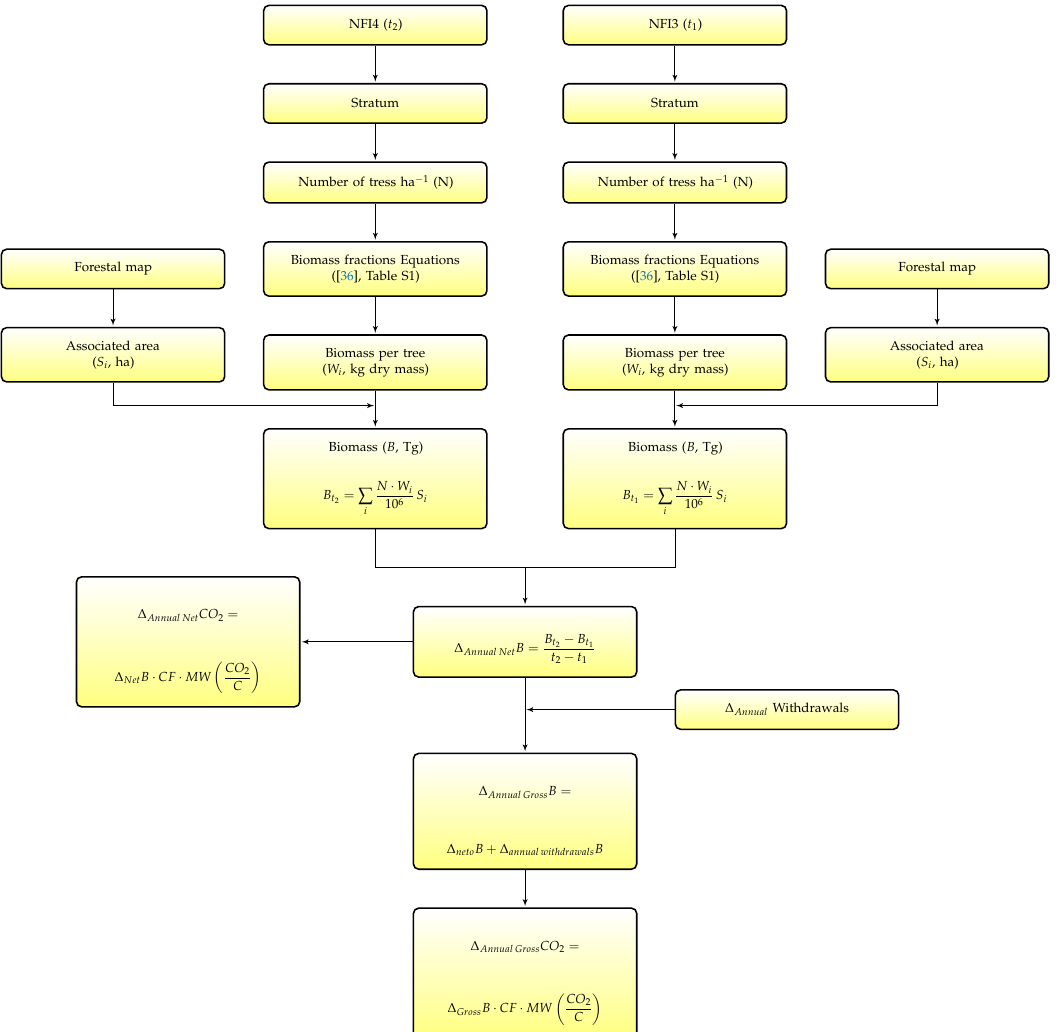
Figure 2. Schematic diagram of the method followed to determine biomass and carbon stock. The usual methods proposed in the literature to determine the total biomass and its fractions use different independent variables such as tree diameter at breast height (DBH) measured 1.3 m above